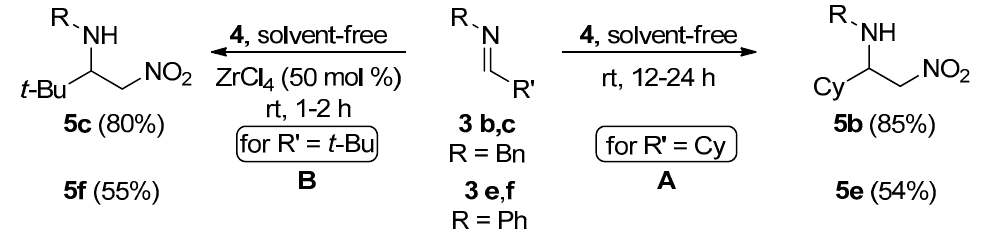
Figure 2. Proposed outcome for the ZrCl 4 -catalyzed addition.